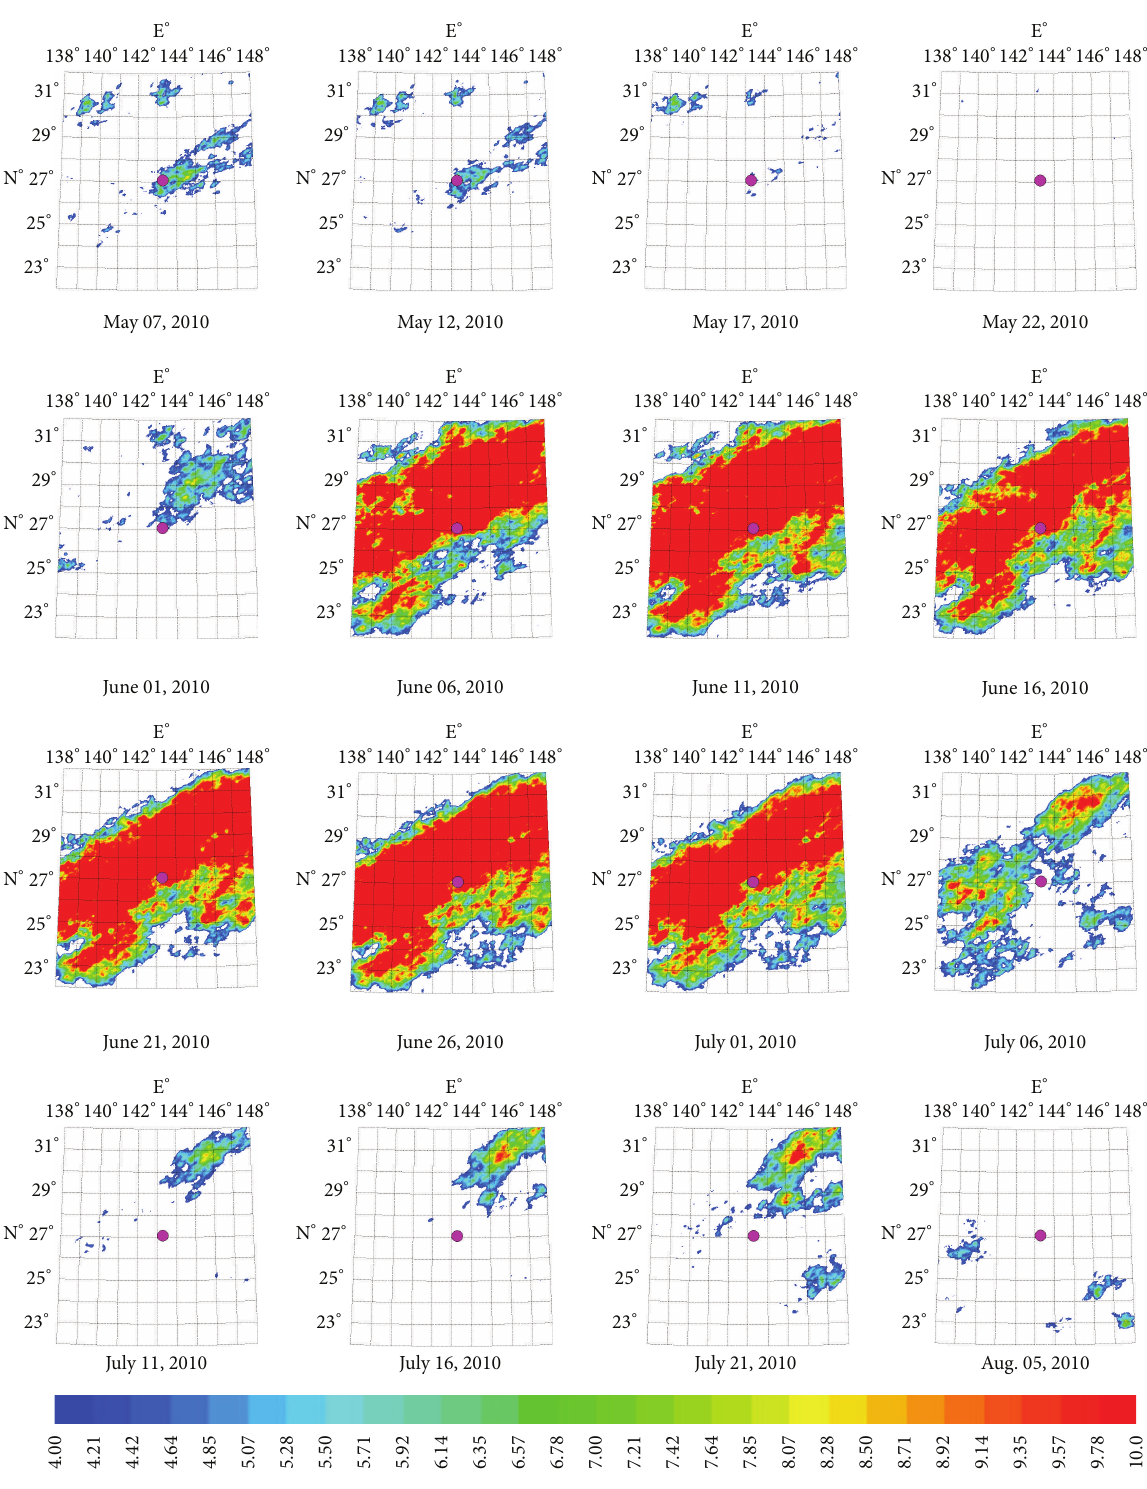
Figure 7: Space-time evolution of Bonin Islands Ms 7.4